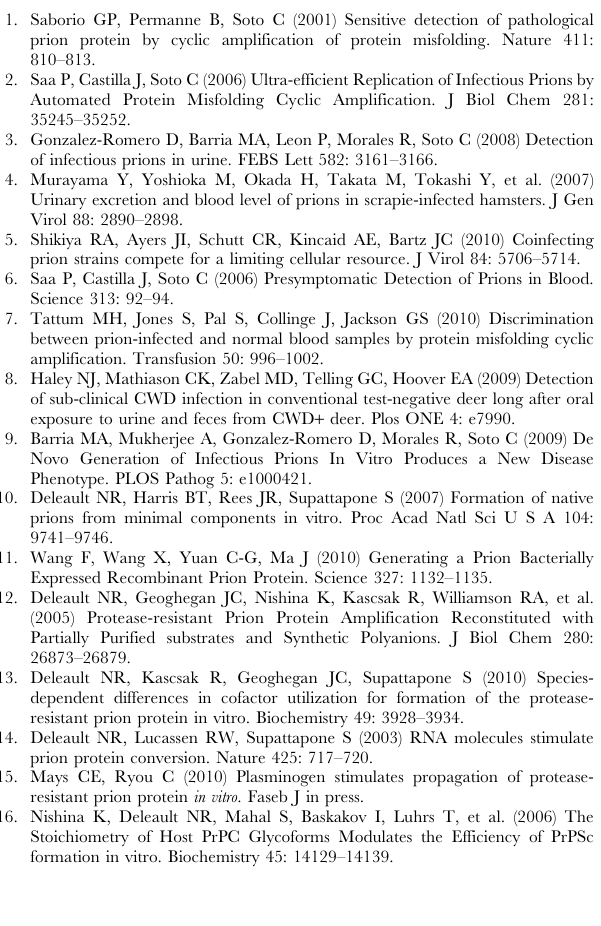
Figure S3 Quantitative estimates of PrP Sc amplification fold. (A) 263K scrapie brain material was serially diluted into 10% NBH to the final concentrations of scrapie brain ranging from 10% to 0.0625%, then digested with 50 m g/ml PK for 1 h at 37 u C and analyzed using a 96-well dot blot. The signal intensity was measured using a Typhoon 9200 Variable Mode Imager and was found to be linear within the concentrations of scrapie brain homogenate from 0.0625% to 1% as shown in panel B. This concentration range was used to estimate the fold amplification of PrP Sc in PMCA. Figure S4 Analysis of PrP Sc fold amplification in serial PMCA. 263K brain material was diluted 10 4 -fold into 10% NBH (lane 2)